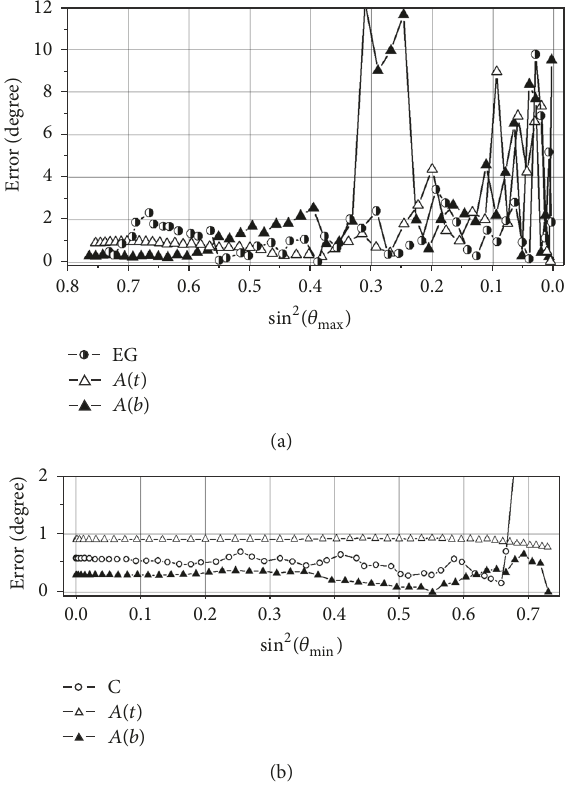
Figure 12: Error for the asymmetric set of azimuths and noise, variant 𝑉 𝑃3 = 4800 ; (a) fixed 𝜃 min and (b) fixed 𝜃 max .